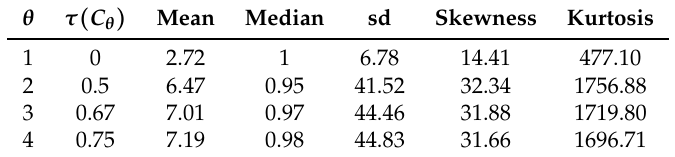
Table 4. Descriptive Statistics for Y = X 1 X 2 when ( X 1 , X 2 ) follows Gumbel copulas.